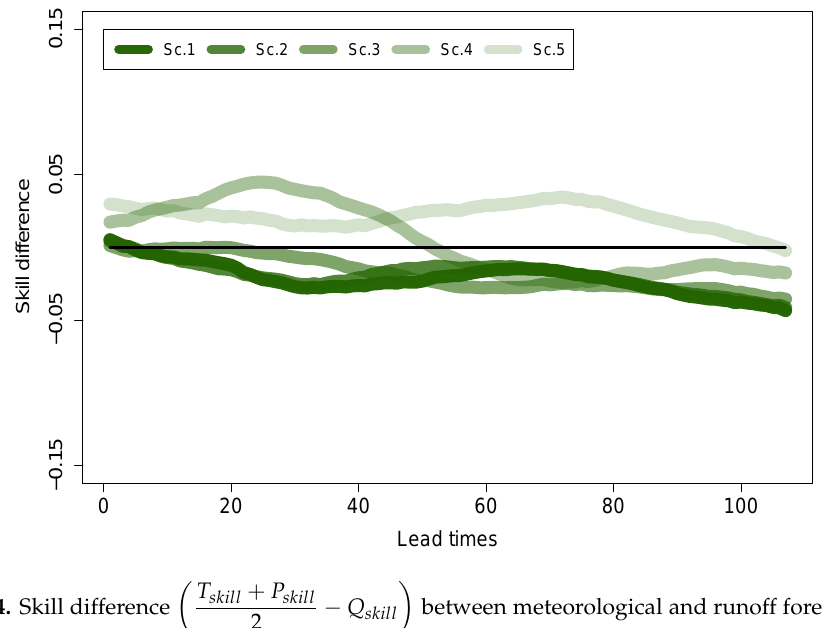
Figure 4. Skill difference all lead times. Individual lines refer to the scenarios (Sc.) defined in Table 2 and are means over the two